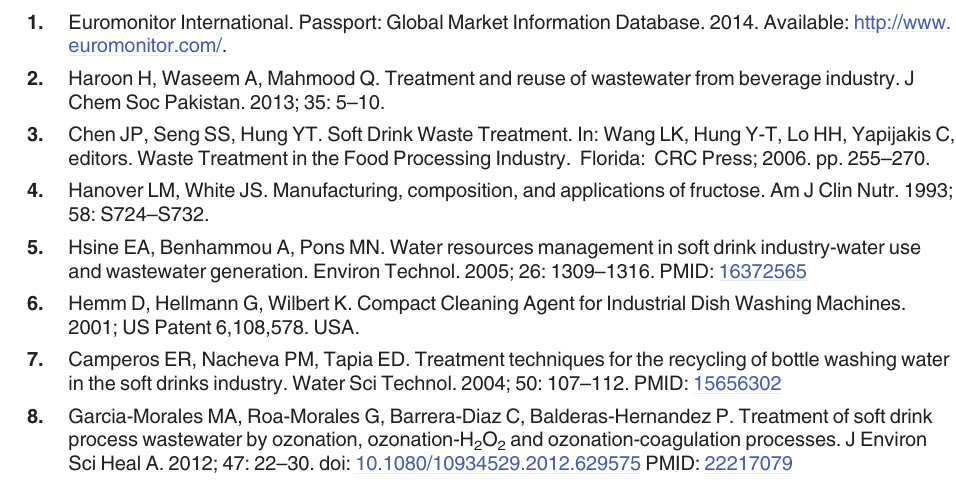
S4 Fig. Correspondence analysis (CA) based on the abundances of 16S rRNA gene OTUs. A and H indicate the samples taken from the anaerobic packed-bed (AP) and hybrid packed-bed (HP) reactors. The numbers following A and H indicate days of the operation for biomass sampling. S5 Fig. Redundancy analysis (RDA) based on the abundances of 16S rRNA gene OTUs of (A) known methanogens, syntrophs and Geobacter populations and (B) the phyla Bacteroi- detes , Chloroflexi , Firmicutes , and Spirochaetes and candidate phyla KSB3 and GN04 popu- lations. S1 Table. Pyrosequencing results of 16S rRNA genes amplicon reads from anaerobic packed-bed (AP) and hybrid packed-bed (HP) reactors. S2 Table. Microbial community composition of anaerobic packed-bed (AP) and hybrid packed-bed (HP)